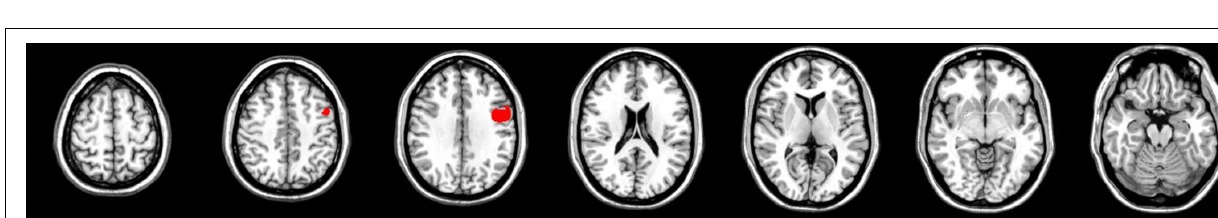
FIGURE 2 | Results for the CV measure, 2000ms.